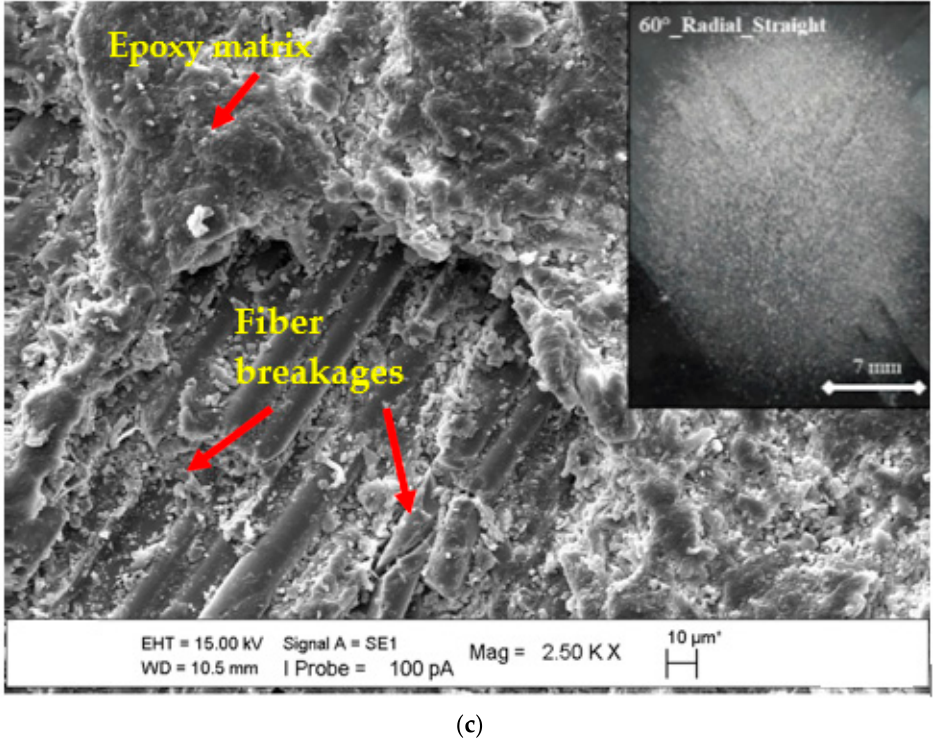
Figure 13. SEM images of matrix damages and fiber breakage on the surface at the 60° impingement angle with radial orientation: ( a ) lamina region, ( b ) zigzag opposite, and ( c ) zigzag straight.